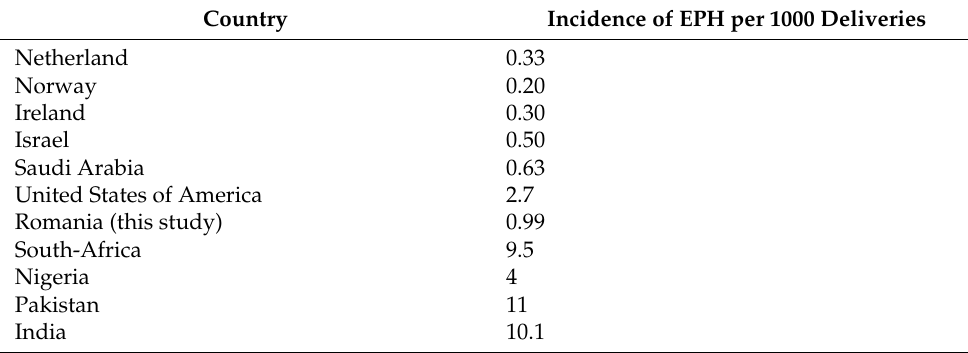
Table 5. Incidence of EPH around the world per 1000